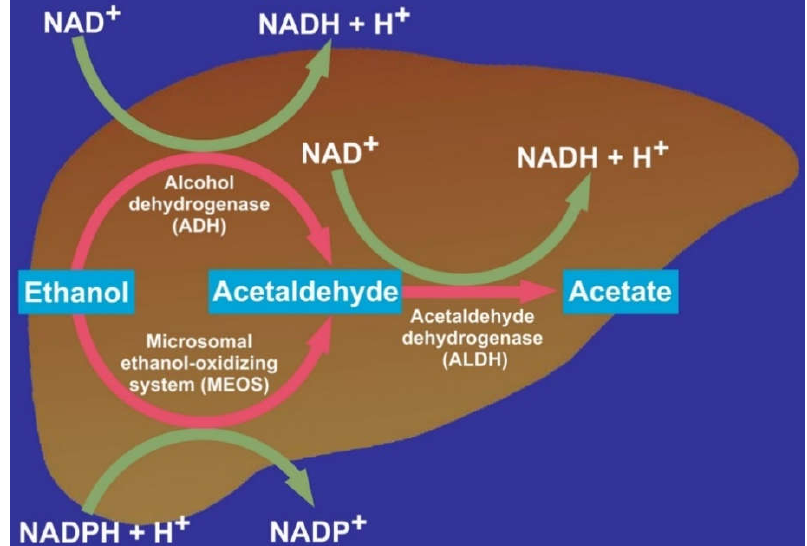
Figure 1. Significant pathways of hepatic alcohol and acetaldehyde metabolism. For alcohol metabolism, presented are cytosolic alcohol dehydrogenase (ADH) and the microsomal ethanol‐ oxidizing system (MEOS); both pathways metabolize ethanol to acetaldehyde. Reproduced from a previous report [25], with permission of the Publisher Taylor & Francis (Didcot, UK).